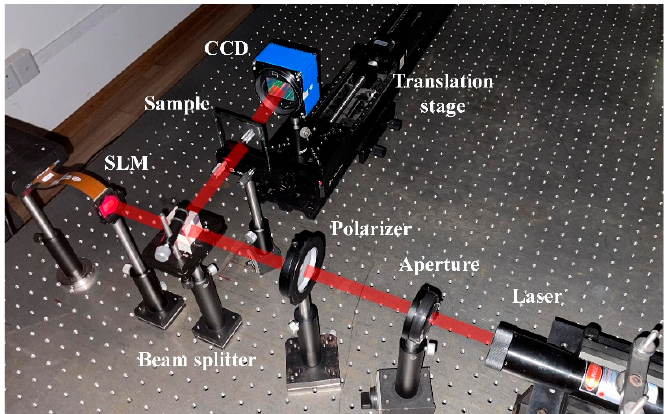
Figure 8. The experimental imaging setup of the proposed phase retrieval.